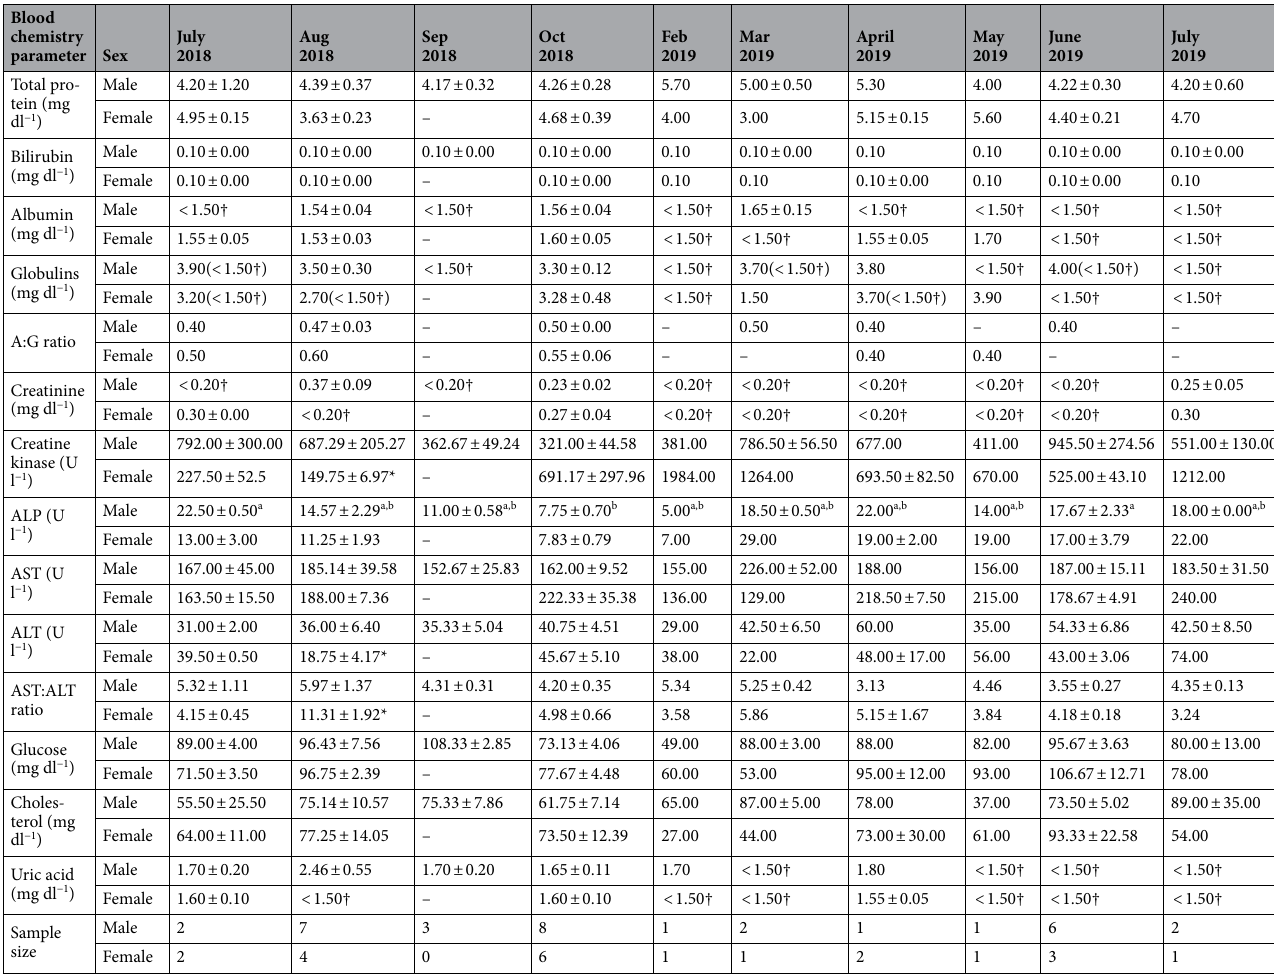
Table 2. Plasma biochemistry parameters in juvenile American alligators ( Alligator mississippiensis ) sampled in the wild. Dissimilar letters show significant differences between months within the given sex. *Significant difference between males and females during the indicated month (p < 0.05). †Values below detection limit. Values shown are averages ± SEM. SEM is not shown in cases including only one animal. Outliers excluded from analyses are shown in